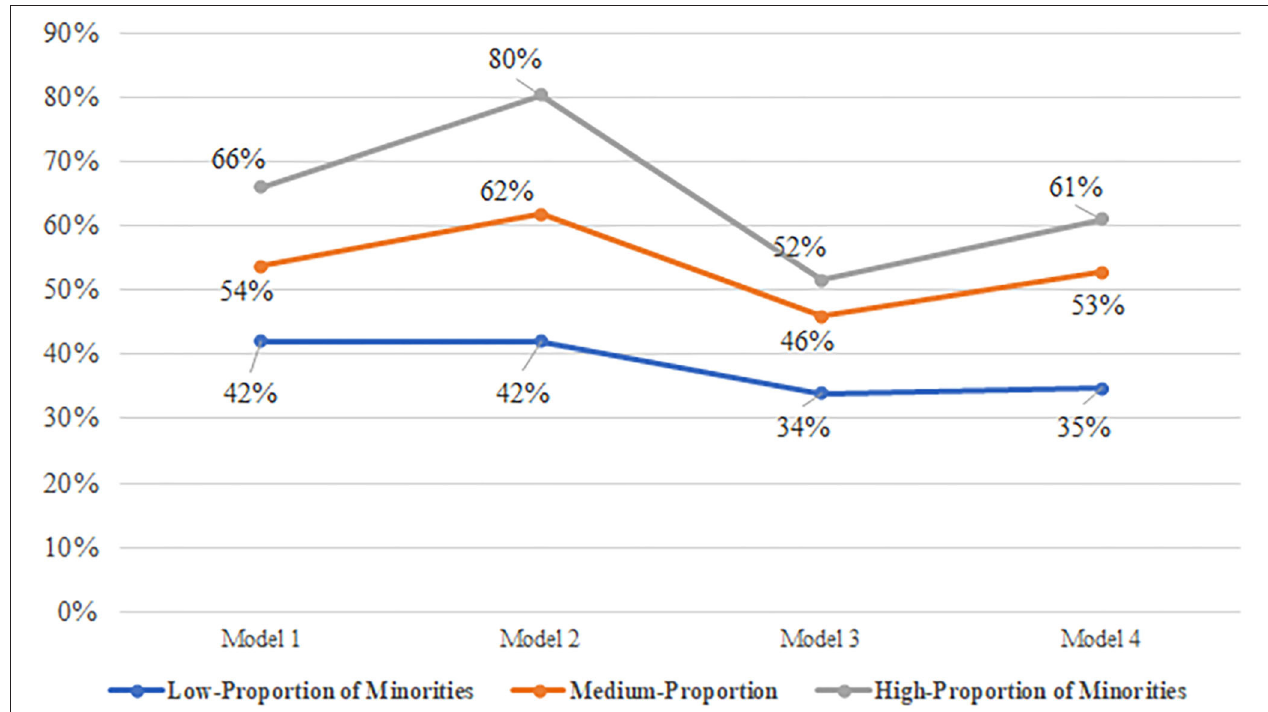
FIGURE 2 | Incidence rate ratios of COVID-19 mortality by resident racial/ethnic mix ( n = 12,914). CMS nursing home COVID-19 public file, brown University’s LTCFocus, and Robert graham center’s social deprivation index. No minorities is reference group; Low-proportion of minorities (0 < minority > 13.3 of Blacks/Hispanics); Medium-proportion of minorities (13.3 < minority < 30.3 of Blacks/Hispanics); High-proportion of minorities (30.3 < minority). Incidence rate ratios calculated from the negative binomial regression averaging over the remaining covariates. Model 1: Controlled for interstate differences and size. Model 2: Variables from model 1,and including facility-level resident characteristics. Model 3: Variables from model 2, and including resource availability. Model 4: Variables from model 3, and including organizational